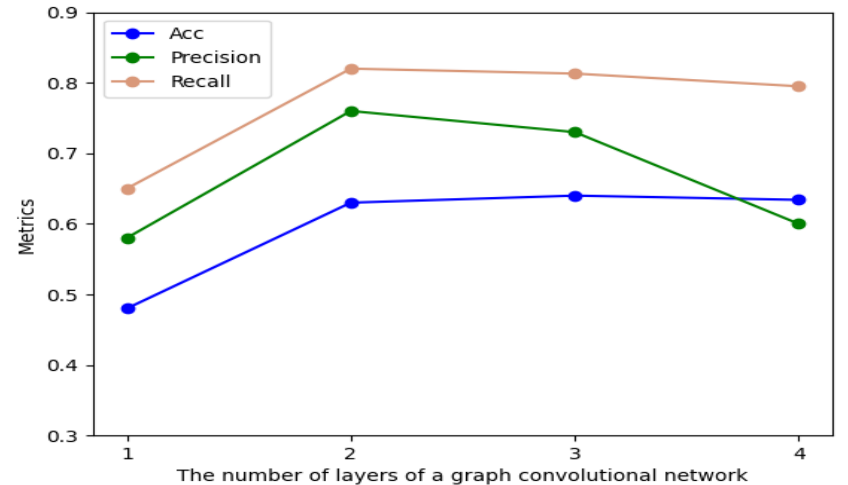
Figure 8. Effect of the number of layers of GCN on the experiment on the Steam-200k